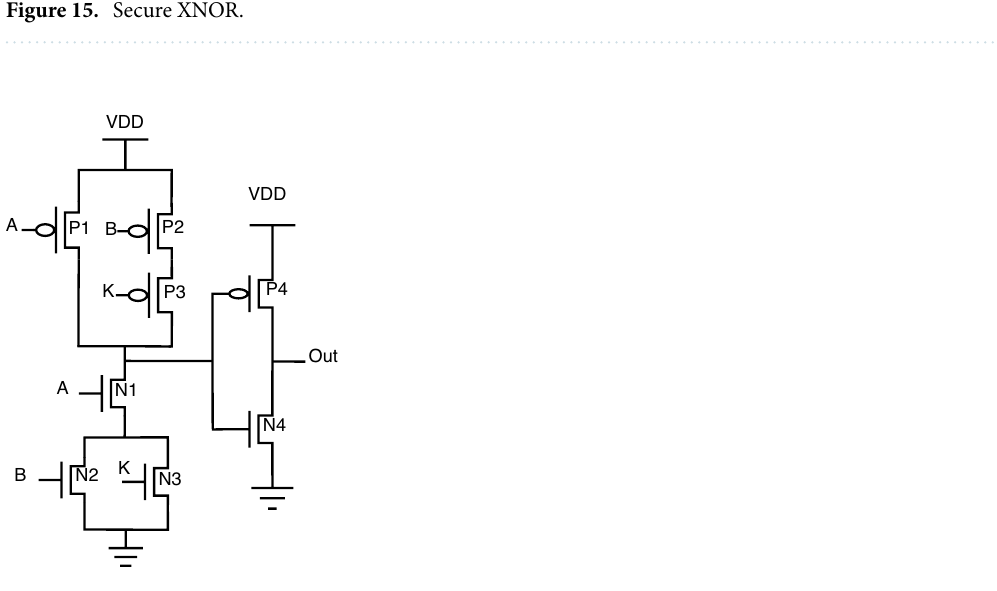
Figure 16. Secure